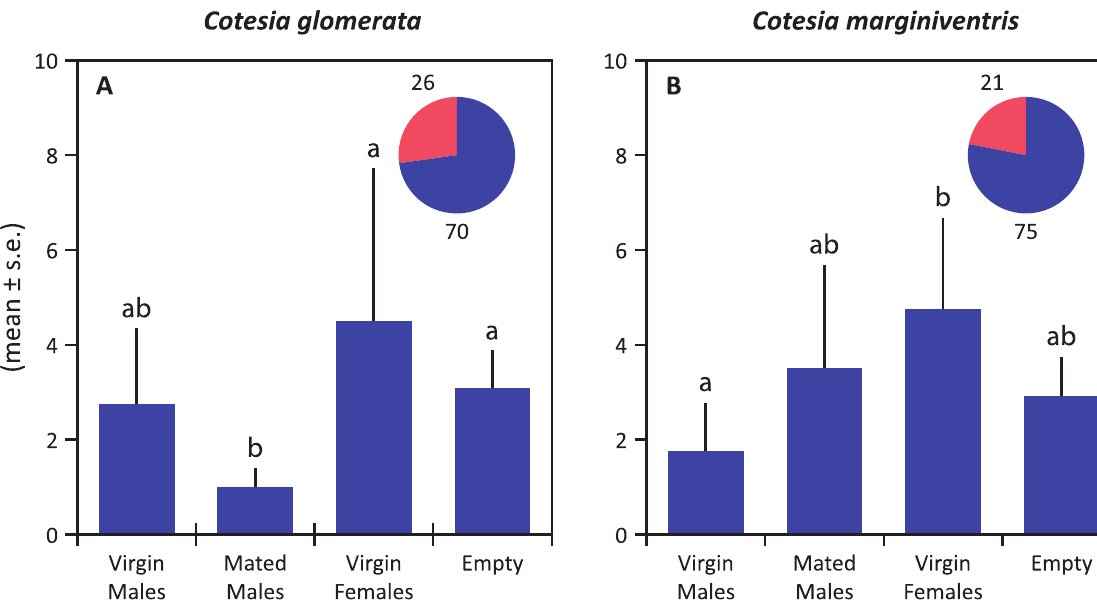
Figure 3. Responses of virgin females to conspecific virgin males, mated males and virgin females in C. glomerata ( A ) and C. marginiventris ( B ) in a six-arm olfactometer . The proportion of wasps that showed no response, i.e. , that did not choose an arm, is given in red in the pie chart, supplemented with the absolute numbers of wasps. Statistical differences ( p < 0.05) are indicated with different letters above the